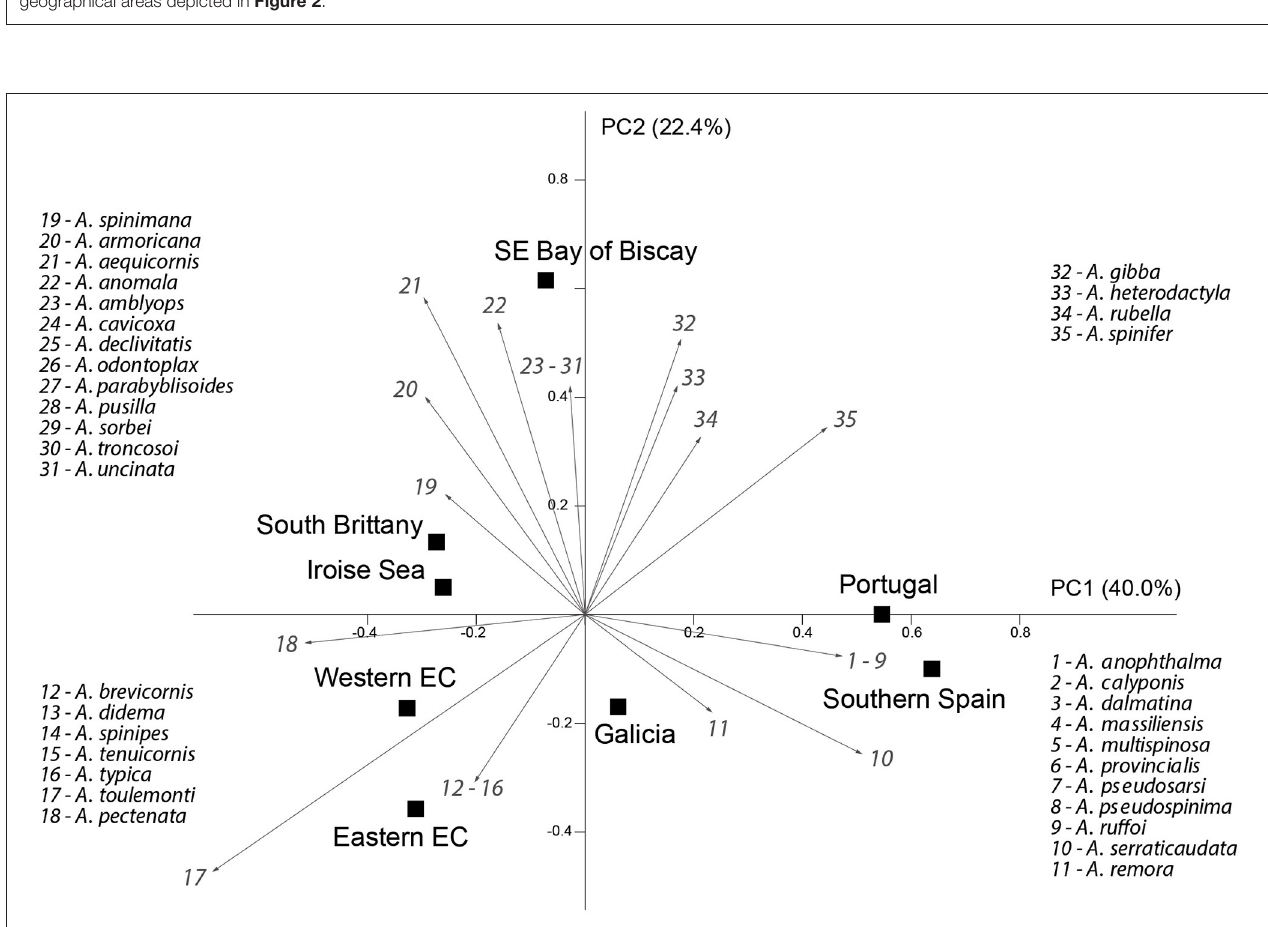
FIGURE 3 | Cluster analysis (dendrogram) and ordination analysis (nMDS) of the Jaccard similarity matrix among the Ampelisca samples representing the geographical areas depicted in Figure 2 .